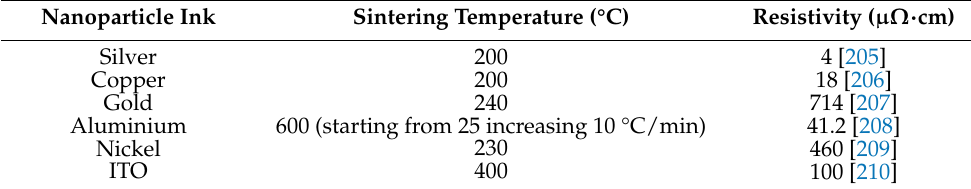
Table 5. Comparison of different sintering temperatures for different nanoparticle inks on glass